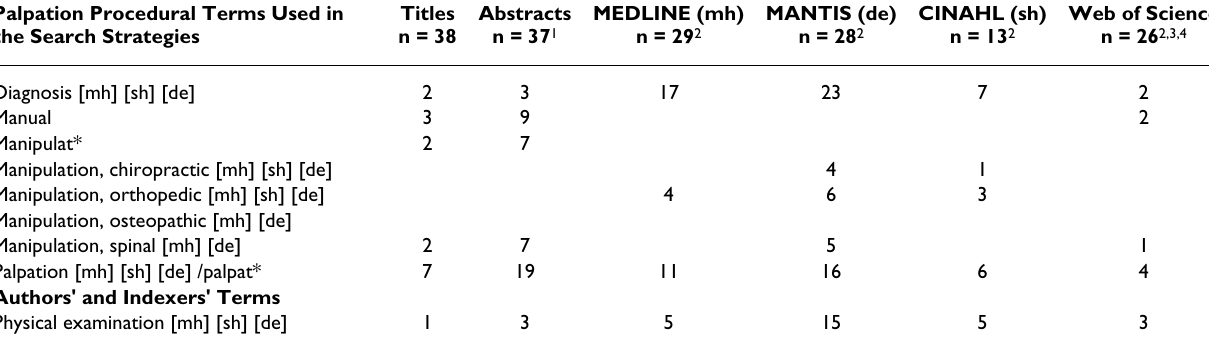
Table 4: Frequency of palpation procedural terms in titles, abstracts and four databases Palpation Procedural Terms Used in the Search